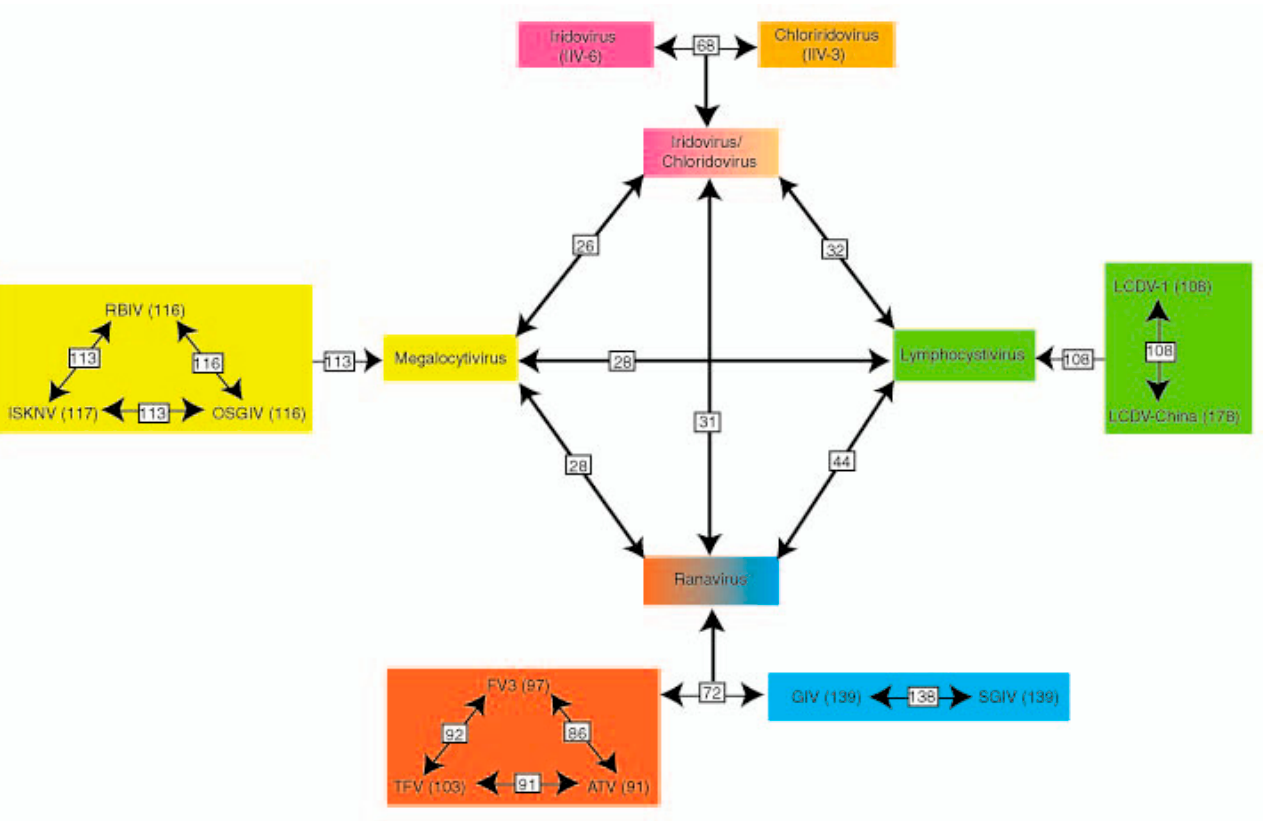
Figure 1. Phylogenetic relationships between iridovirus genera (shown in different colors) based on gene content (Eaton et al., 2007). Phylogenetic relationships between the five iridovirus genera based on gene content. The viral species were compared within a genus to identify the number of orthologous genes. Orthologous genes between viral genera were then specified. The numbers on each line identify the number of orthologous genes shared among viral species or genera comprising the 26 core genes. The Iridovirus and Chloriridovirus genera have a high level of gene conservation and a shared genera box ( Iridovirus / Chloriridovirus ) was used to compare orthologous genes between genera.